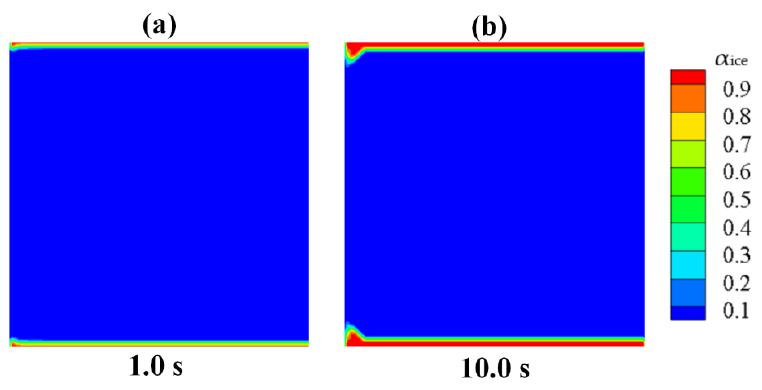
Figure 8. Contours of ice phase fraction at various moments for case 2 ( a ) 1.0 s and ( b ) 10.0 s.